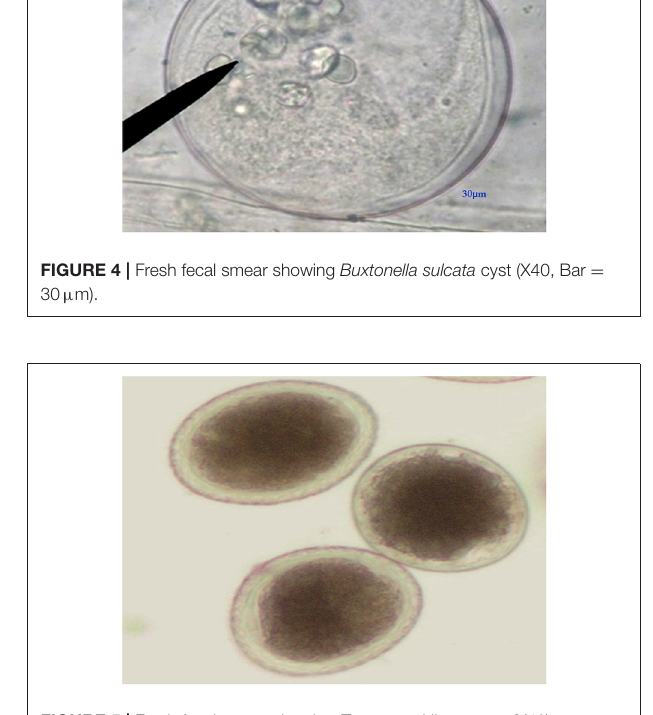
FIGURE 5 | Fresh fecal smear showing Toxocara vitiluram egg (X40).